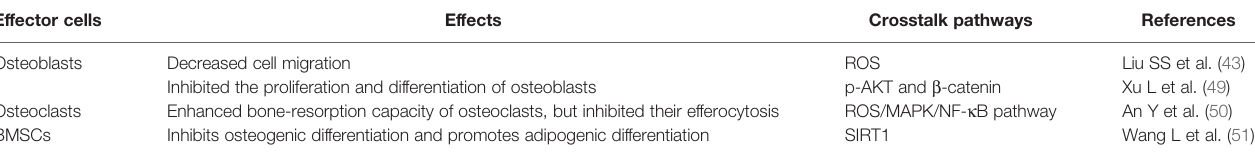
TABLE 1 | The different effects of NLRP3 in fl ammasome on bone